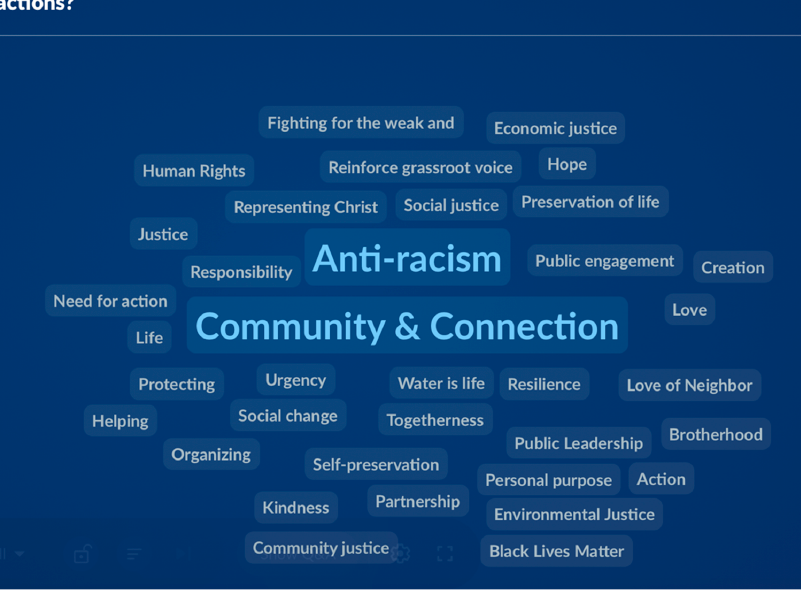
Figure 2. Values: an image of the slido poll capturing values underlying the above actions.